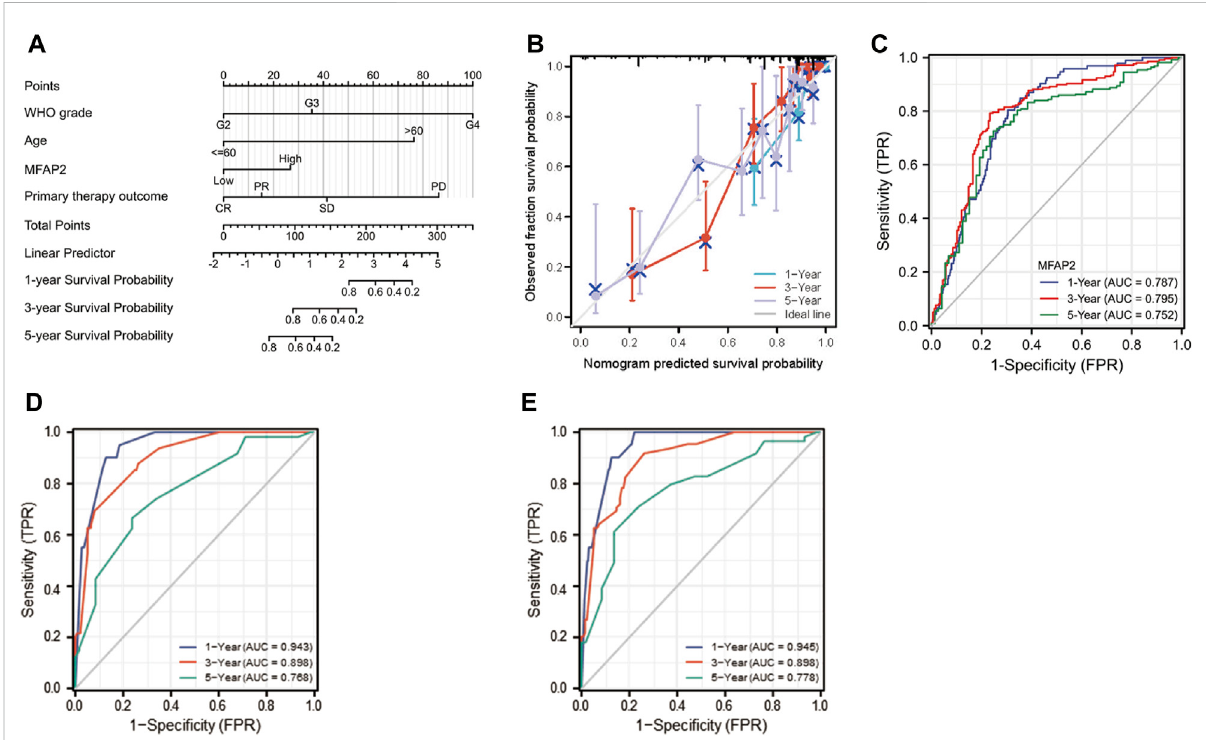
FIGURE 8 Construction of MFAP2-related prognostic nomogram. (A) Nomogram survival prediction in patients with glioma. The top row presents the point valuefor eachvariable. (B) The calibration curvedisplays thedifference between themodel prediction of1-, 3-, and5-yearssurvival andactual survival outcomes. (C) Time-dependent ROC curve AUC validated the effect of mfAP2-based risk score on prognosis. (D) Time-dependent ROC curveAUCvalidatedtheeffectsofWHOgrade,primarytherapyoutcome,age,IDHstatus,and1p/19qcodeletionbasedriskscoreonprognosis. (E) Time-dependent ROC curve AUC validated the effect of WHO grade, primary therapy outcome, age, IDH status, and 1p/19q codeletion of the MFAP2-based risk score on